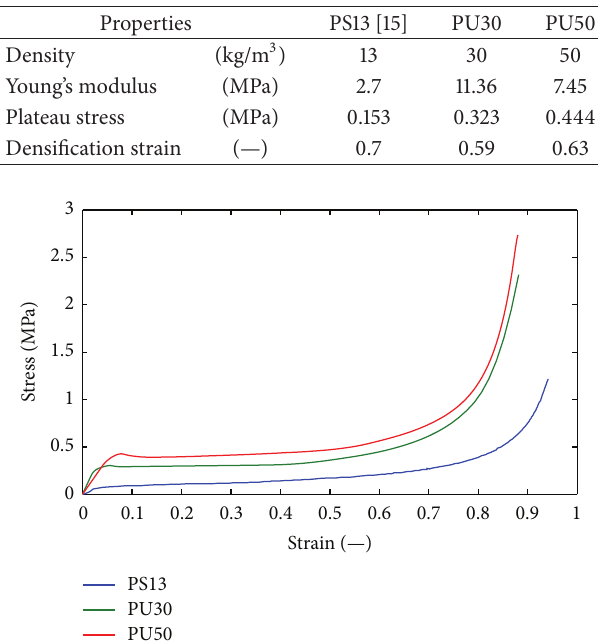
Figure 2: Stress-strain response of PS13 (0.001s −1 ) [15], PU30, and PU50 (0.083 s −1 ) under quasi-static compression.